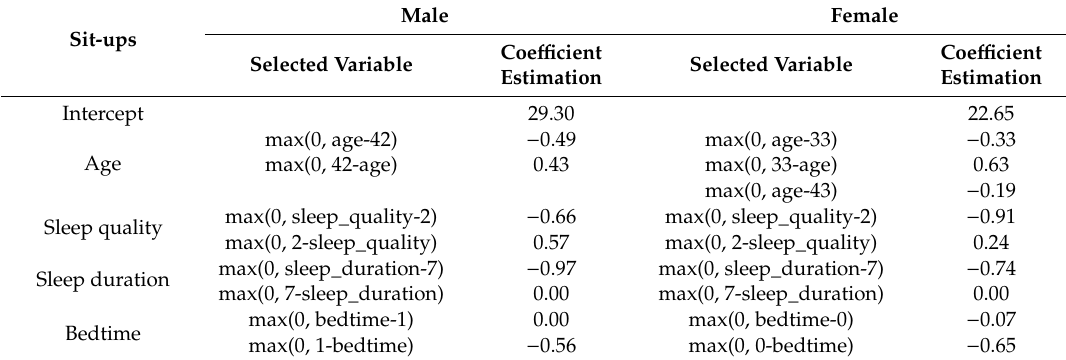
Table 5. Estimation results for sit-ups by